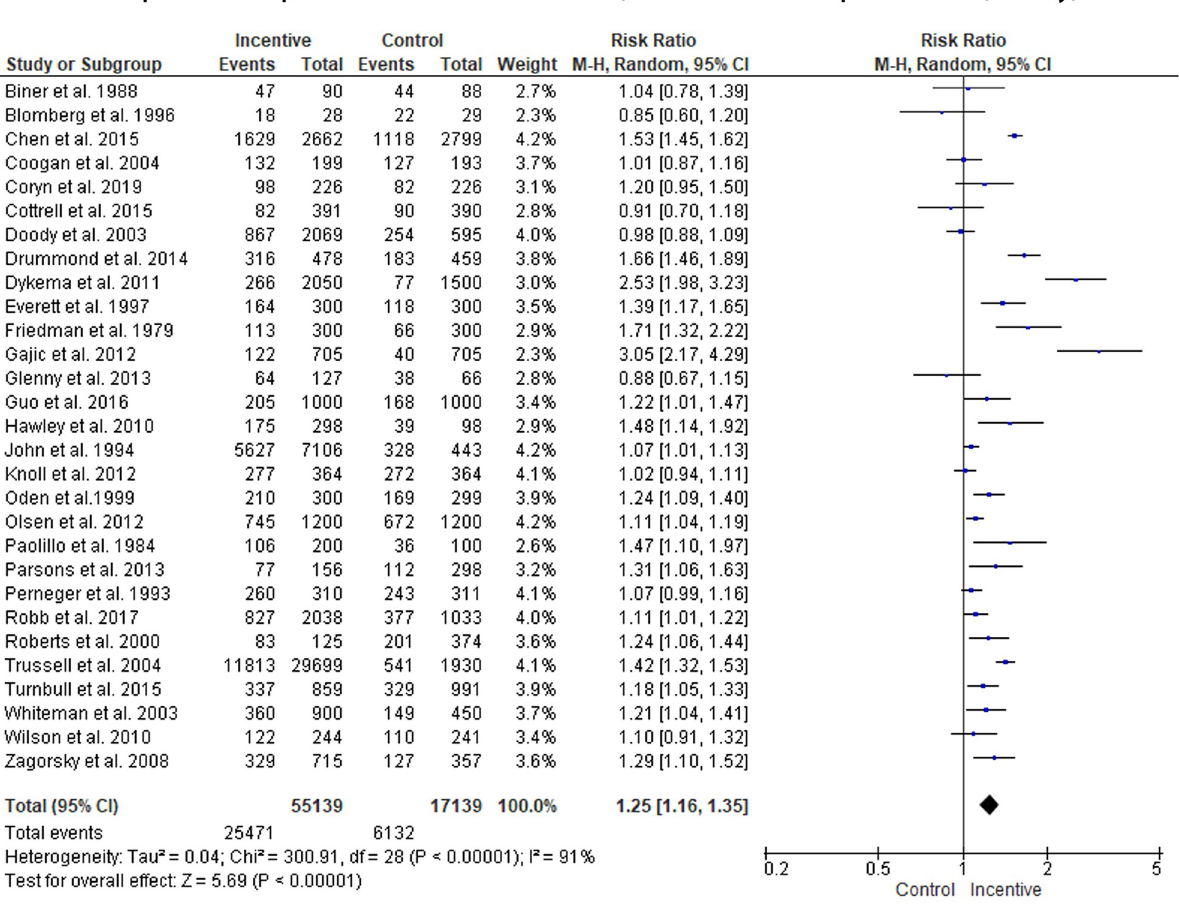
Fig 3. Forest plot of the effect of money in response rate. df: degrees of freedom; I 2 : I-squared; M-H: Mantel-Haenszel variance; CI: confidence interval.